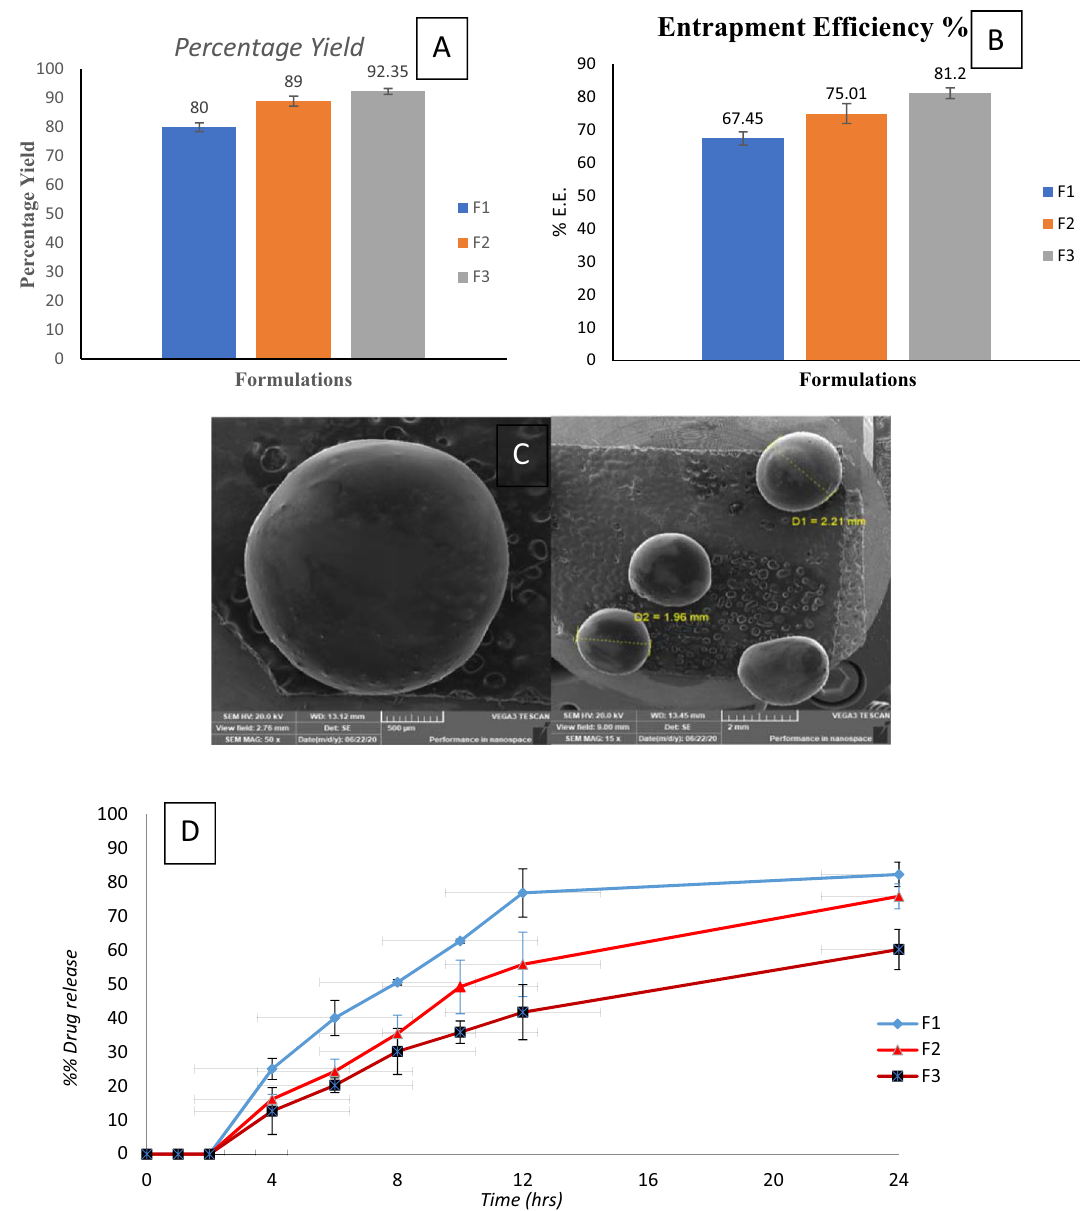
Figure 1. Characterization of B.V. loaded cross-linked chitosan-coated microspheres: ( A ) Percentage yield, ( B ) Entrapment Efficiency %, ( C ) SEM image of surface morphology ( D ) In vitro release profile in different pH media.